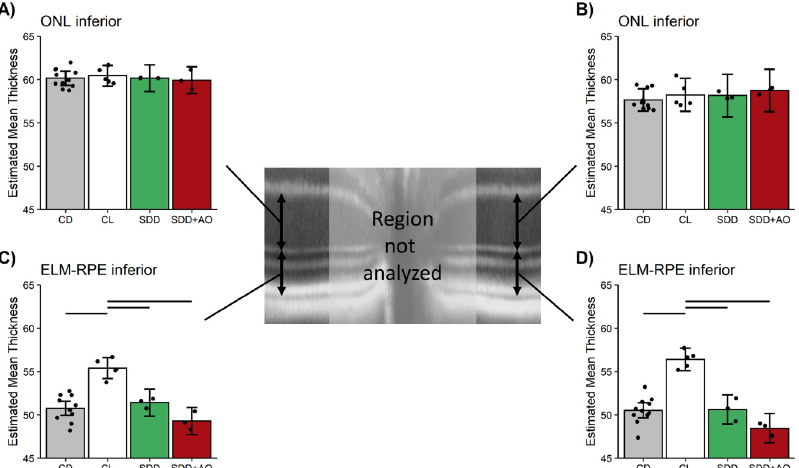
Fig 8. 1 hr post-sildenafil in dark-adapted mice (SDD, Fig 2) shows thinner ELM-RPE. Modeled A) ONL inferior retina, B) ONL superior retina, C) ELM-RPE thickness inferior retina, and D) ELM-RPE thickness superior retina in uninjected control dark (CD, n = 11 mice, grey bar), control light (CL, n = 5 mice, white bar), SDD+saline (SDD, n = 3 mice, green bar), and SDD+AO (n = 3 mice, red bar) in the two different retinal regions. ONL is constant regardless of condition. In SDD+saline and SDD+AO groups, ELM-RPE thickness is not different from CD (and was thinner than CL); no evidence for oxidative stress was found. The points in each plot represent the estimated mean for each mouse based on the model. Error bars indicate 95% confidence intervals. Note the same control bars are presented in each graph to facilitate comparisons.